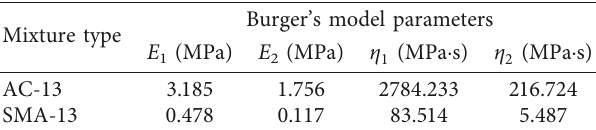
Table 5: Burger’s model